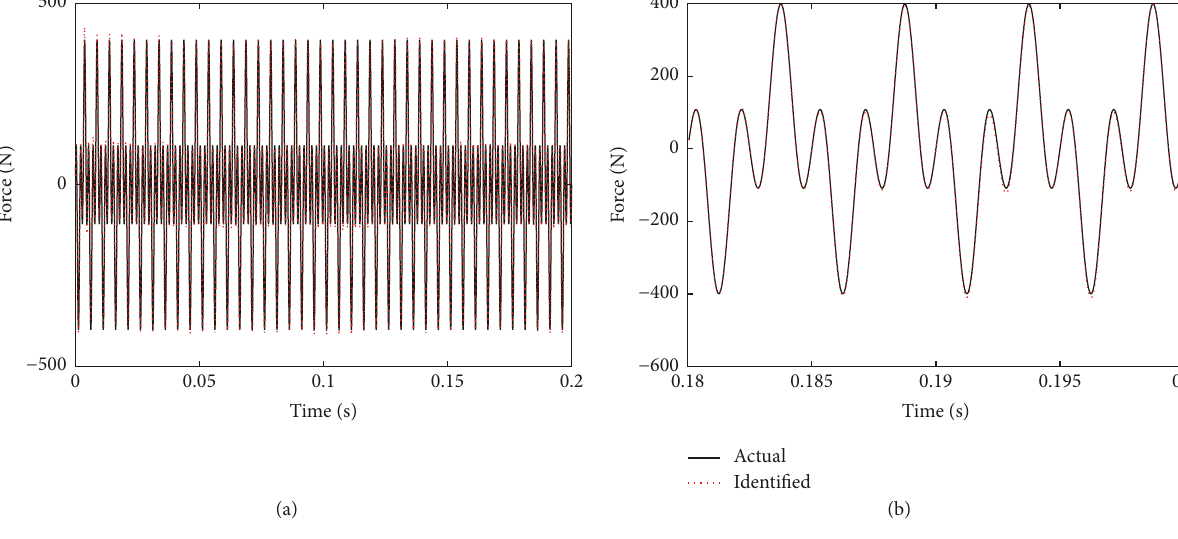
Figure 14: The actual and identified results of force 𝑢 by data